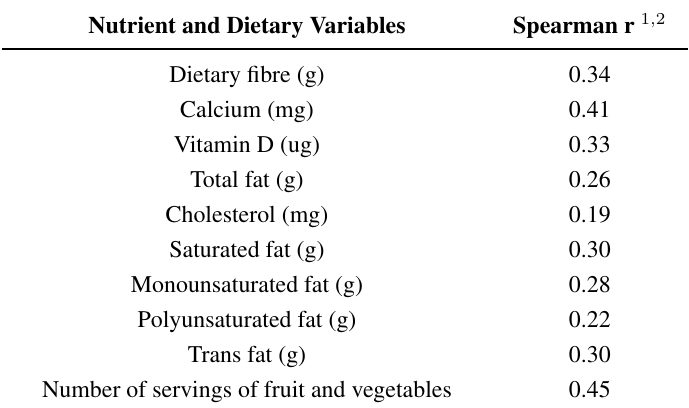
Table 3. Associations between nutrient estimates from SDQ and mean of three non-consecutive 24HR, SDQ validation study ( n =